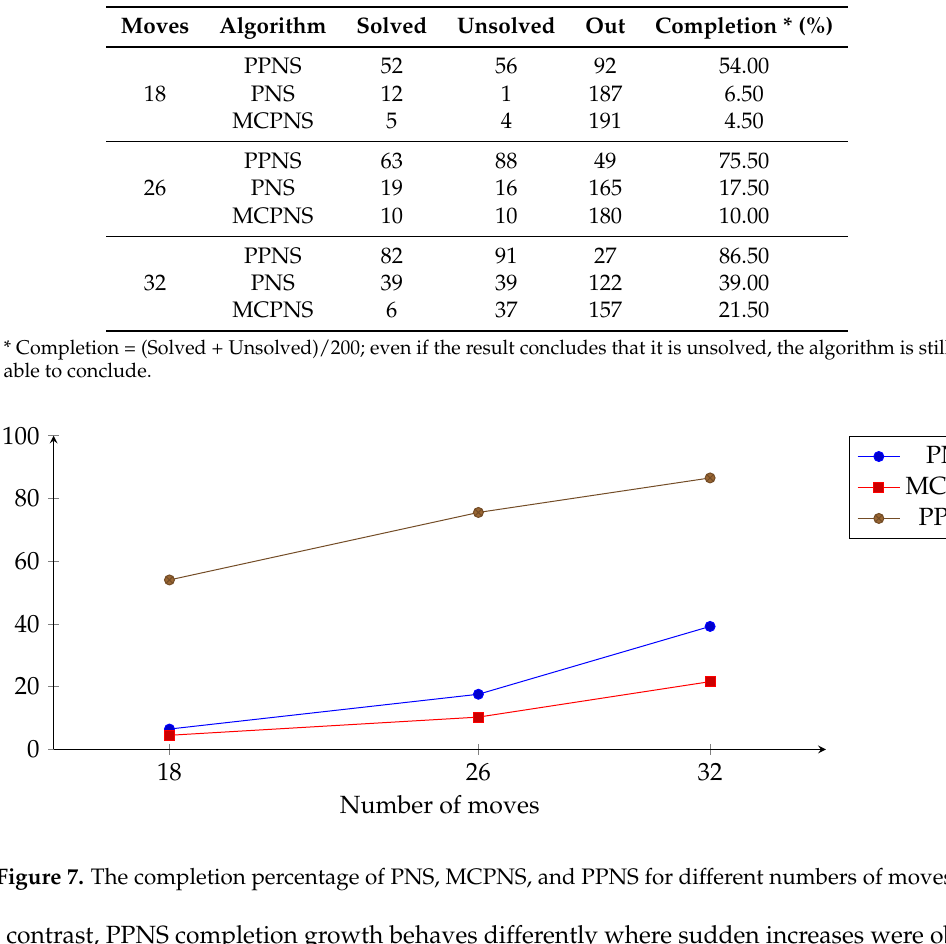
Table 2. Experimental result of different algorithms applied to Othello positions.